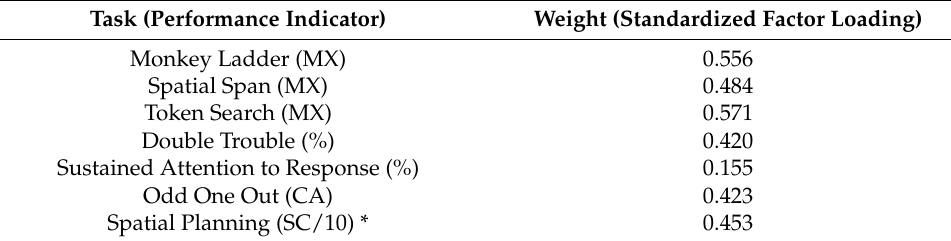
Table A1. Weight for each of the tests as well as for the weighted sum for executive function. Task (Performance